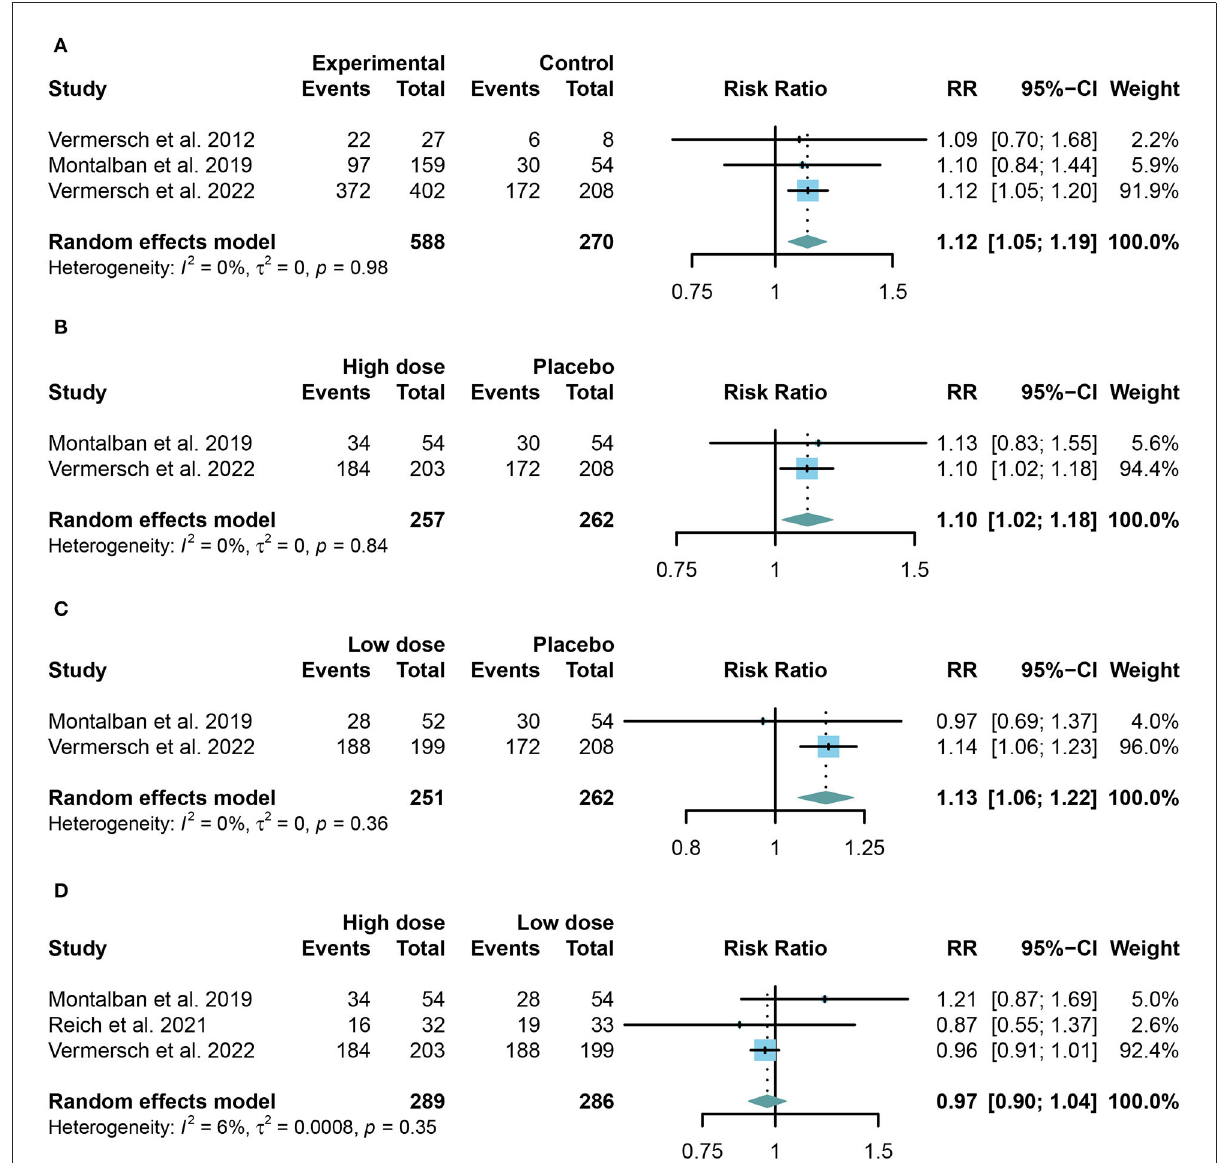
FIGURE4 The pooled risk ratios (RRs) of patients with adverse events in different treatment doses compared with the placebo group; the diamond indicates the estimated summary RRs with a 95% confidence interval (CI). (A) Summary of different doses of TKIs compared with the placebo group; (B) high dose of TKIs compared with the placebo group; (C) low dose of TKIs compared with the placebo group; and (D) high dose of TKIs compared with low dose